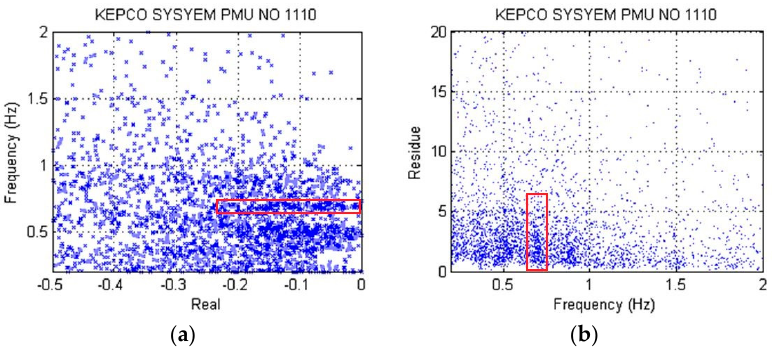
Figure 12. Distribution of the mode and residue estimated by MuPRO. ( a ) Mode; and ( b ) residue.